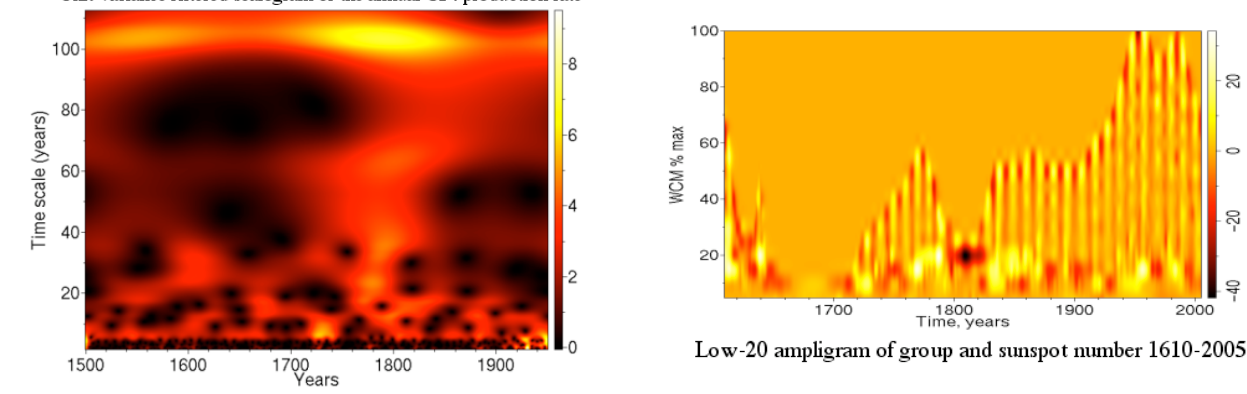
Fig. 7. Unit-variance filtered scalogram of the 14 C production rate from 1500–1950.